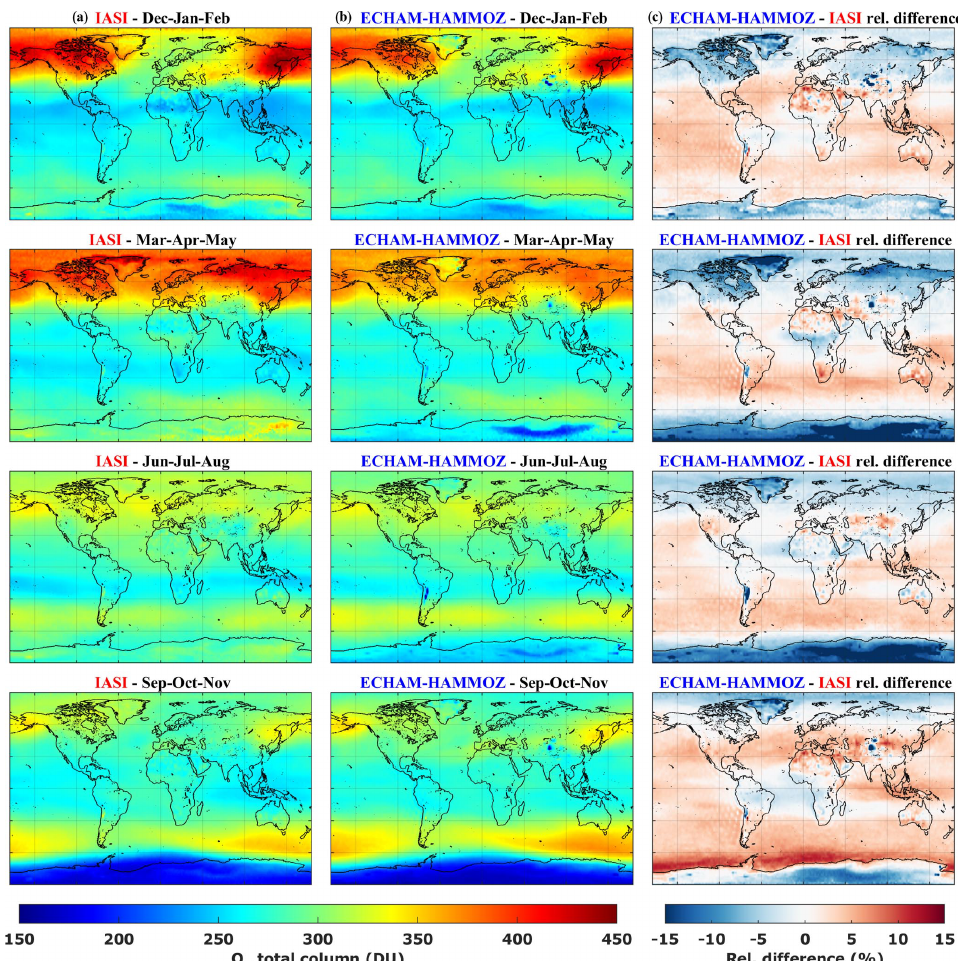
Figure 1. (a, b) Comparison of seasonal mean total column ozone (in DU) from ECHAM-HAMMOZ with data from the IASI instrument. Data and model results are from 2008. IASI data were interpolated onto the model grid and averaging kernels were applied to the model data. (c) TCO relative differences (in %) between ECHAM-HAMMOZ and